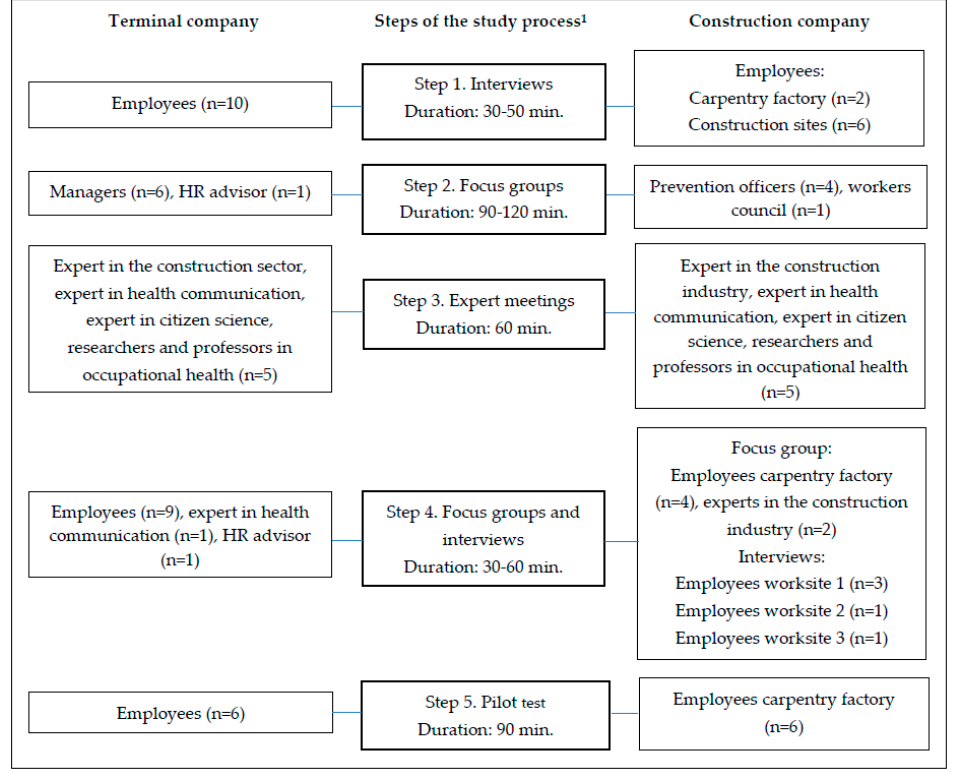
Figure 2. An overview of the participants in all steps of research. 1 See Figure 1 for an explanation of the steps. HR = Human